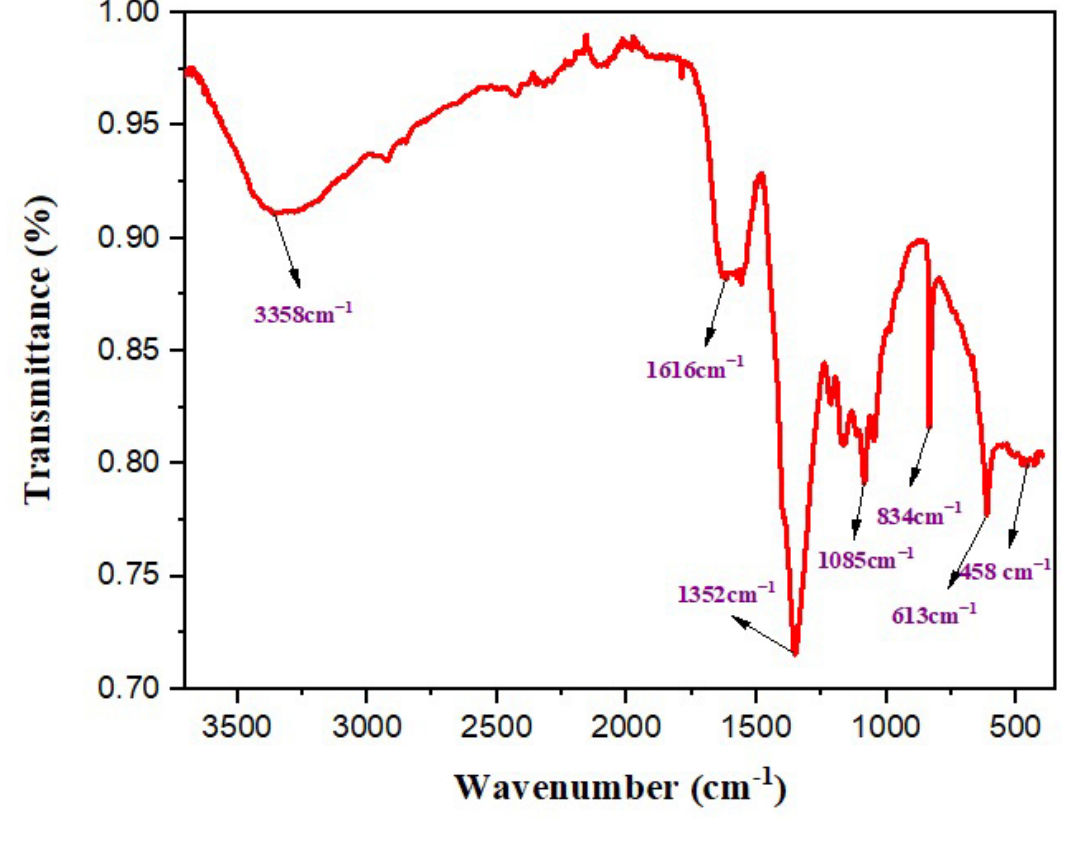
Figure 3. FTIR spectrum of biogenic CuO NPs.